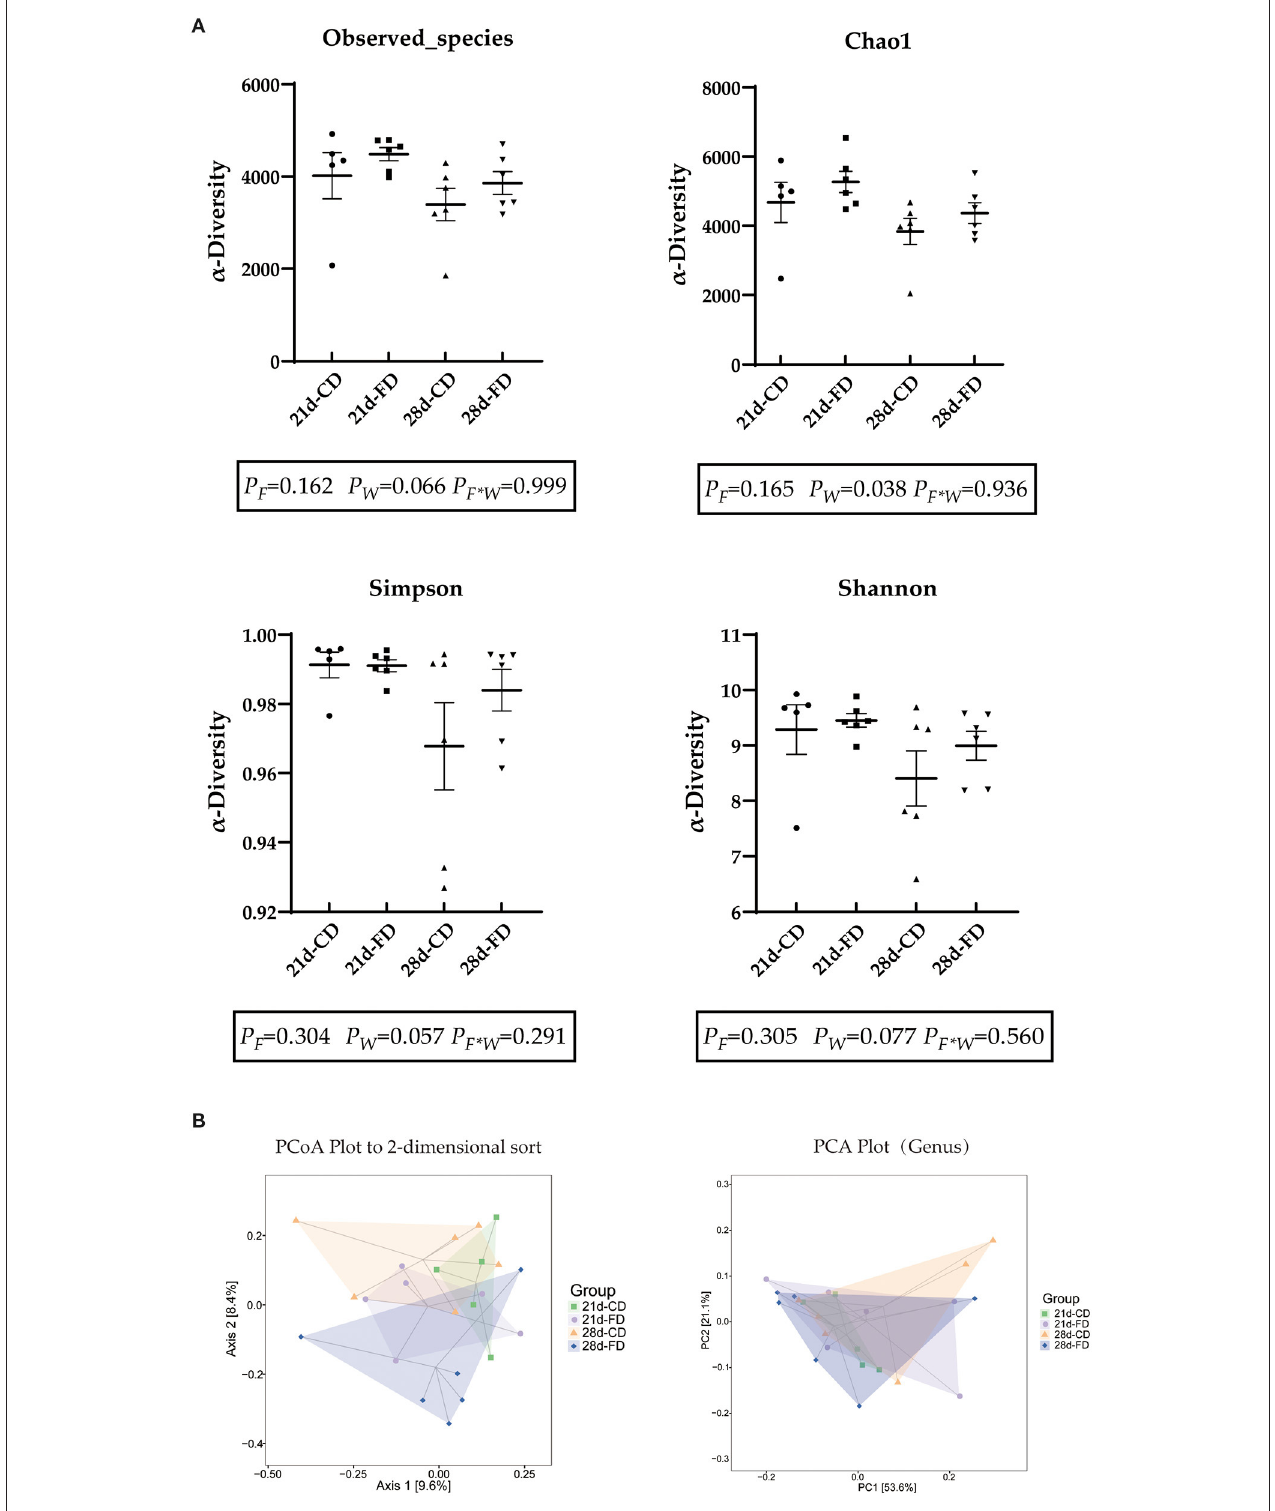
FIGURE 5 | The effects of fermented diet and weaning age on the cecal microbial composition of piglets. (A) Observed-species, Chao1 index, simpson index and Shannon index were used to measure α -diversity; (B) Unweighted Unifrac distance-based PCoA plot and OTUsbased PCA plot (genus). 21d-CD, 21-day-old weaned piglets fed the control diet. 21d-FD, 21-day-old weaned piglets fed the fermented diet. 28d-CD, 28-day-old weaned piglets fed the control diet. 28d-FD, 28-day-old weaned piglet fed the fermented diet. F, the main effect of fermented diet. W, the main effect of weaning age. F*W, the interaction effect between fermented diet and weaning age. Values are presented as the mean ±